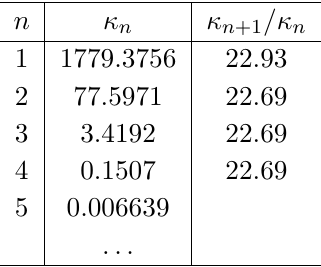
Table 1 . Some energy levels obtained eq. (3.8) for the choice (cid:3) = 10 4 and H ((cid:3)) = 0.